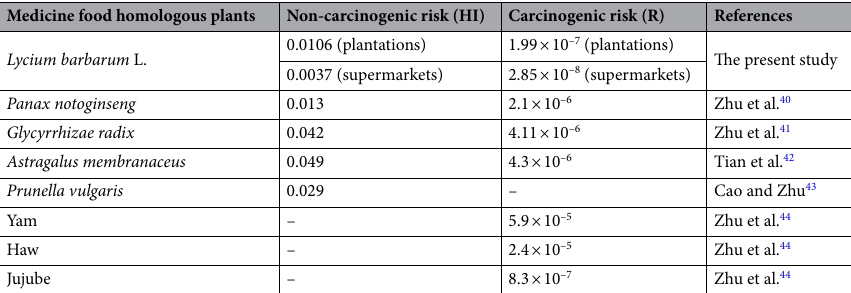
Table 5. The non-carcinogenic health risk and carcinogenic risk of metals in medicine food homologous plants. – means no available